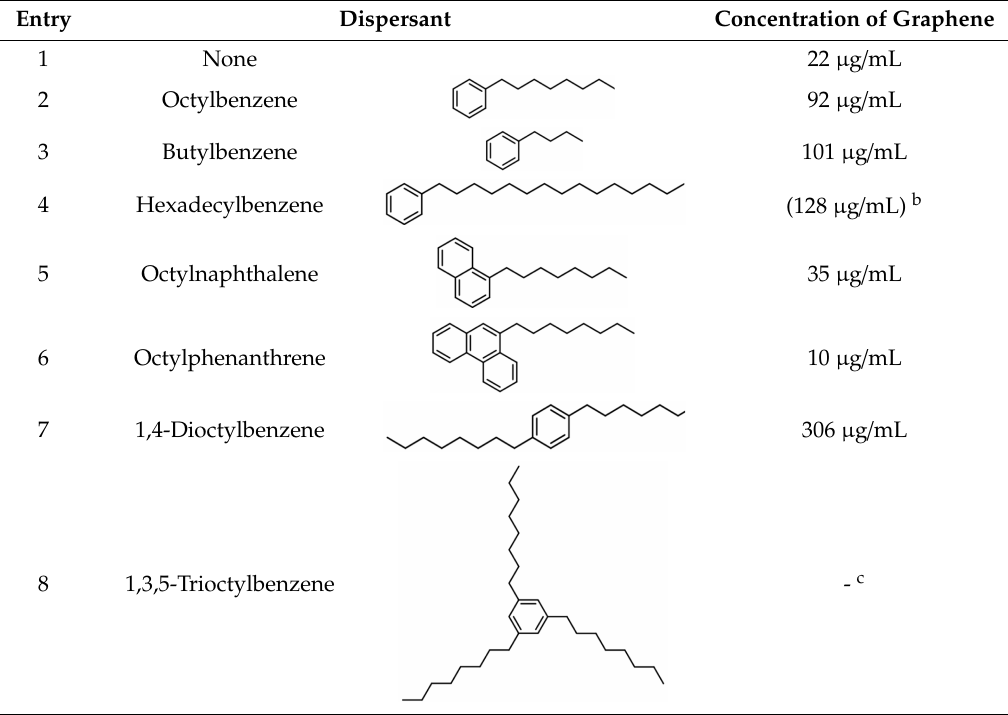
Table 1. Relationship between dispersant structure and the concentration of grapheme a . Entry Dispersant Concentration of Graphene 1 None 22 µ g / mL